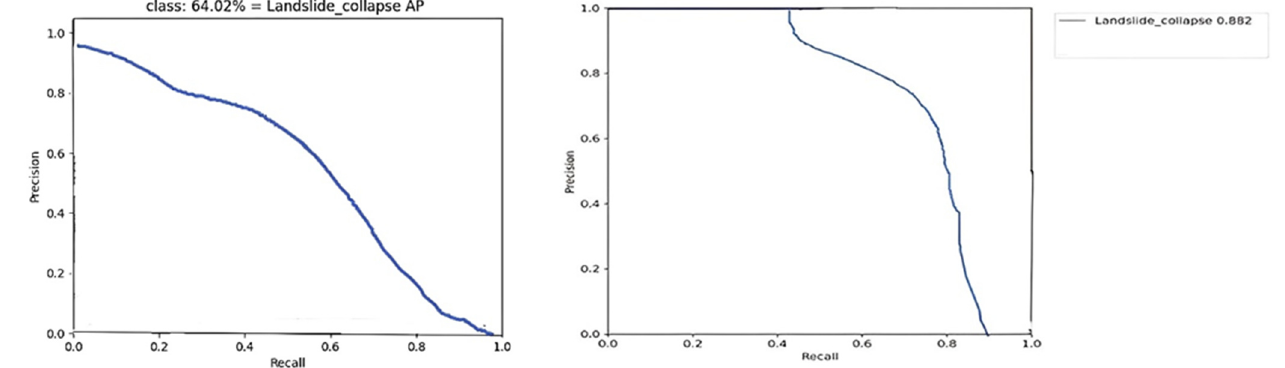
Figure 13. The P-R Curve of the SSD model ( left ) and the transfer learning model ( right ). Figure 13. The P–R Curve of the SSD model ( left ) and the transfer learning model ( right ).